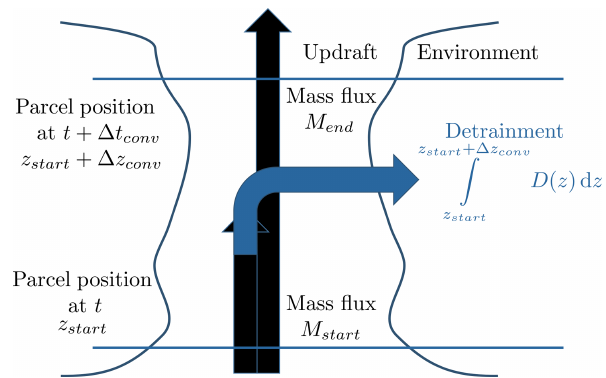
Figure 2. Schematic representation of the detrainment step. All quantities are per unit